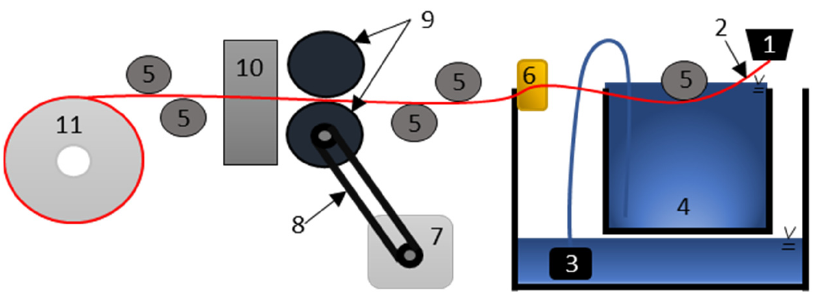
Figure 2. Schematic representation of the filament pulling machine. 1: nozzle of the